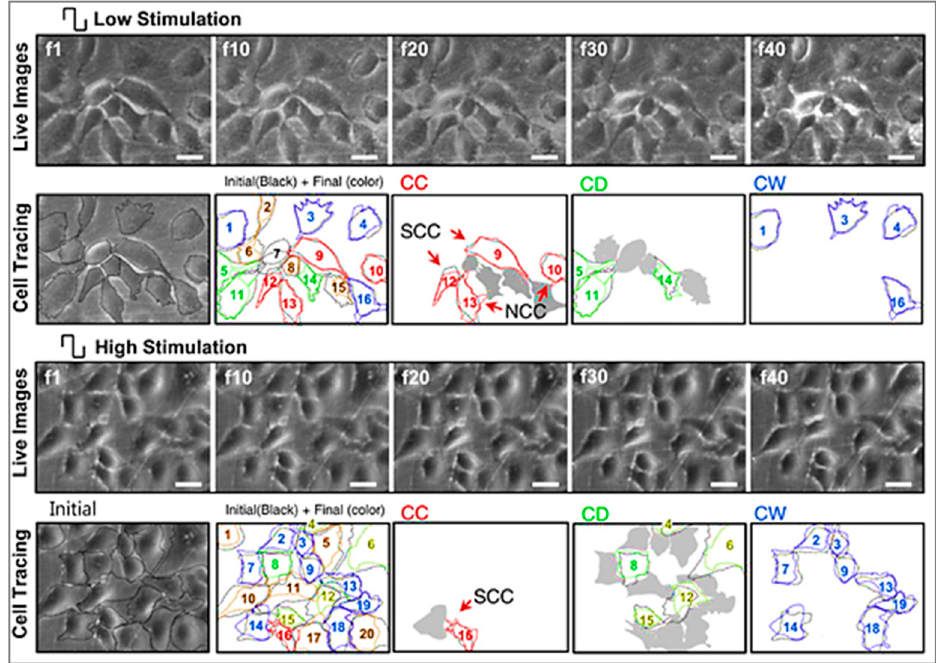
Figure 4. Representative images and analysis of cellular response to electrical stimulation; “f1” to “f40” corresponds to the 1st to 40th image taken during stimulation, using an optical microscope; “f1” cell shapes are outlined in black. The final shapes are then represented by different colors (red for cell-to-cell coupling (CC), green for cell-to-cell decoupling (CD) and blue for cell-to-cell wavering (CW)). (Top, low stimulation) Stimulation at 4.5 mV/mm where CC categorization was observed in the majority of the cells, also with clear newly formed cell-to-cell coupling (NCC) and strengthened cell-to-cell coupling (SCC). (Bottom, high stimulation) Stimulation at 450 mV/mm, where CD and CW